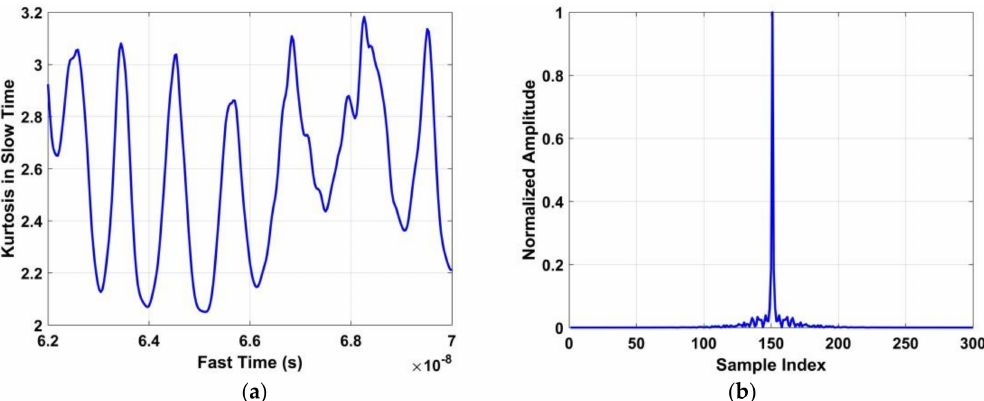
Figure 8. ( a ) The time-domain signal obtained with a human target, and ( b ) the normalized amplitude of the periodic signal in the frequency domain.3.5. Frequency